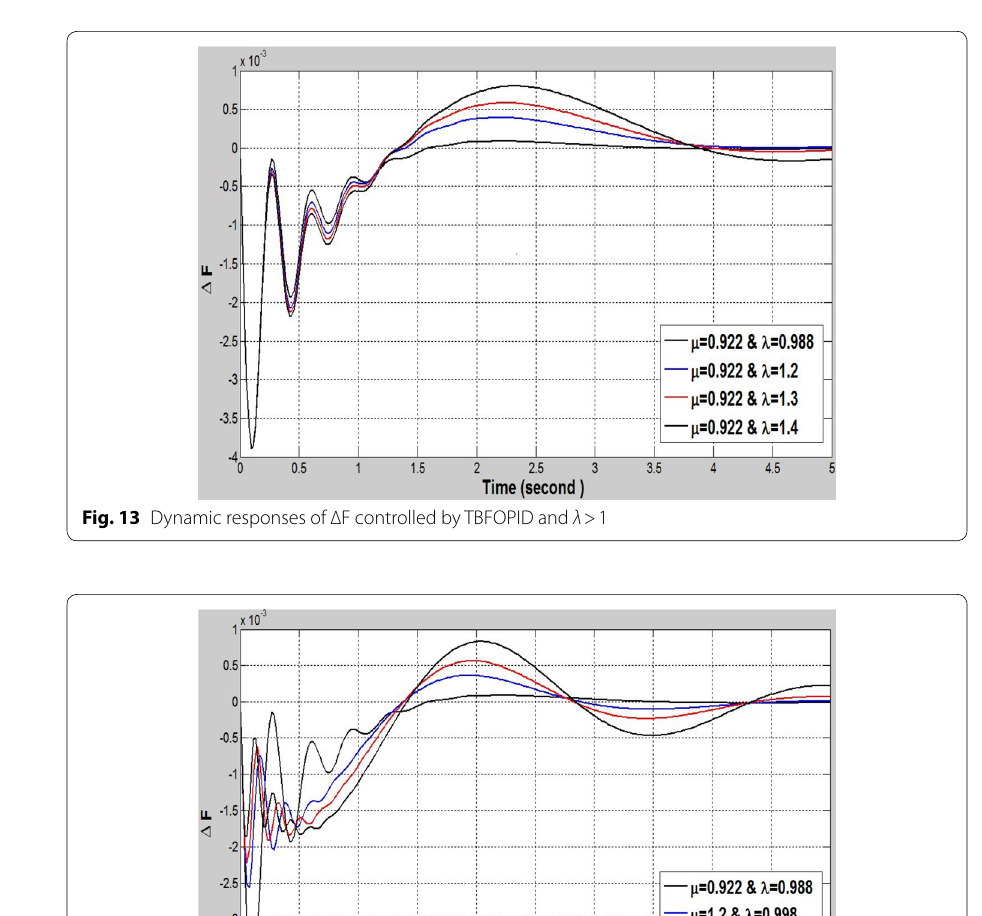
Case 4: Effect of μ for D μ and λ for I λ on TBFOPID controller